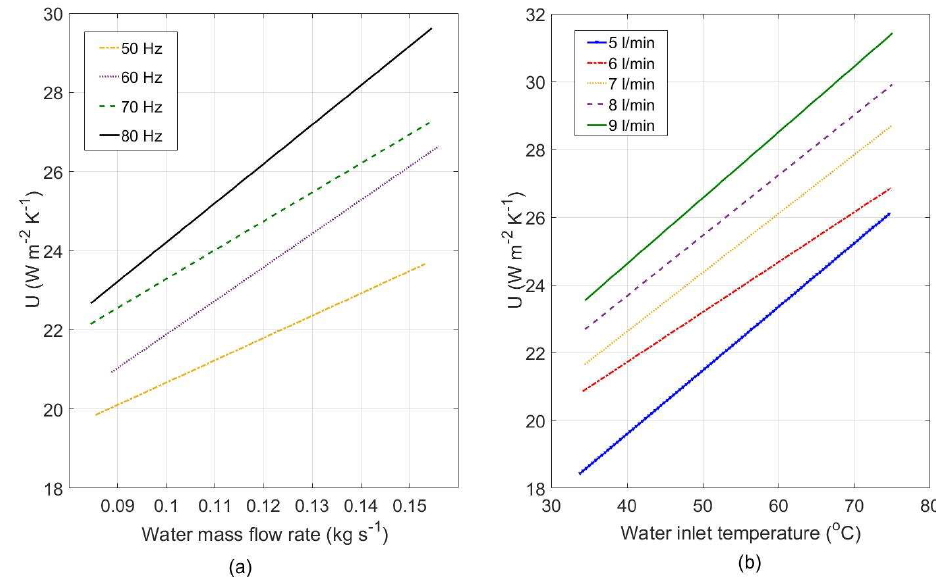
Figure 5. Overall heat transfer coefficient of ( a ) varying mass flow rate and fan frequencies; and ( b ) varying water inlet temperatures and water mass flow rates.